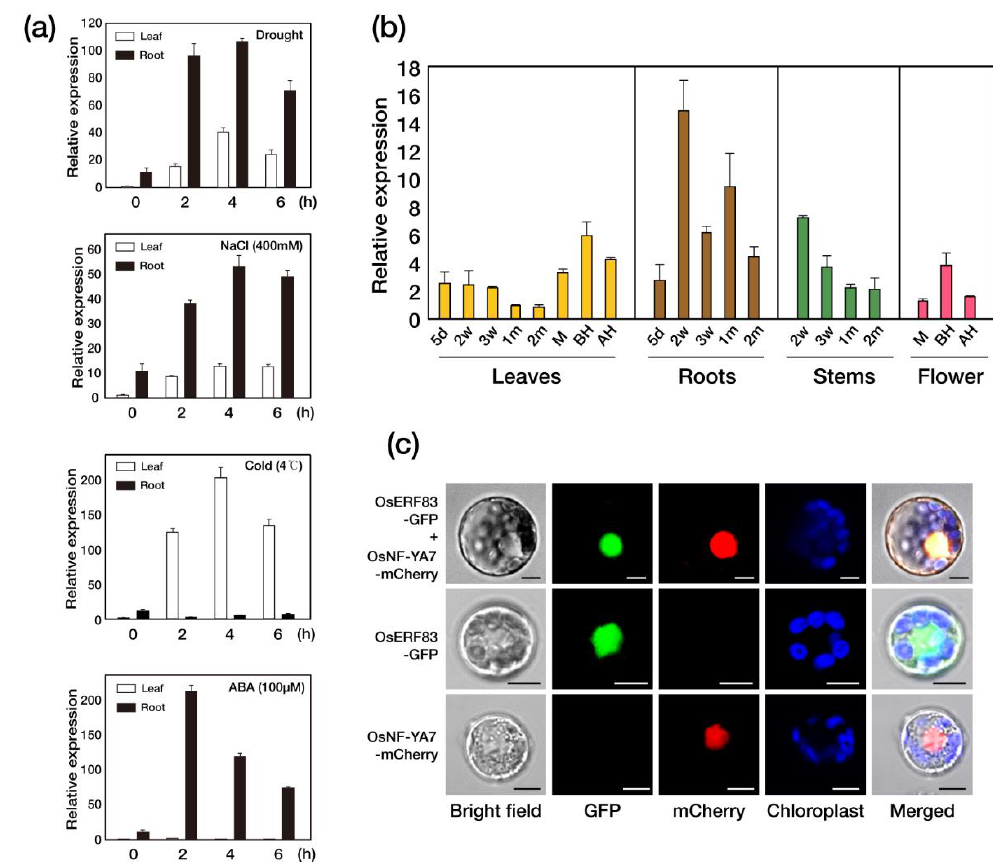
Figure 1. Expression pattern of OsERF83 and subcellular localization of OsERF83 in rice protoplasts. ( a ) The relative expression level of OsERF83 by quantitative RT-PCR in the roots and shoots of 2-week-old seedlings treated with air-drying (drought), 400 mM NaCl (high salinity), 4 °C (cold), and 100 μM abscisic acid (ABA). OsUbi ( Ubiquitin1 ; Os06g0681400) expression was used as an internal control for normalization. Error bars indicate the standard deviation based on three technical replicates. (h: hour) ( b ) The expression level of OsERF83 in various tissues and at different growth stages. (d, day; w, week; m, month; M, meiosis; BH, before heading; AH, after heading). OsUbi1 expression was used as an internal control for normalization. Error bars indicate the standard deviation based on three technical replicates. ( c ) Subcellular localization of the OsERF83 protein in rice protoplasts. 35S::OsERF83-GFP and 35S::OsNF-YA7-mCherry as a control vector were transiently expressed in rice leaf protoplasts. Scale bar, 10 µm.